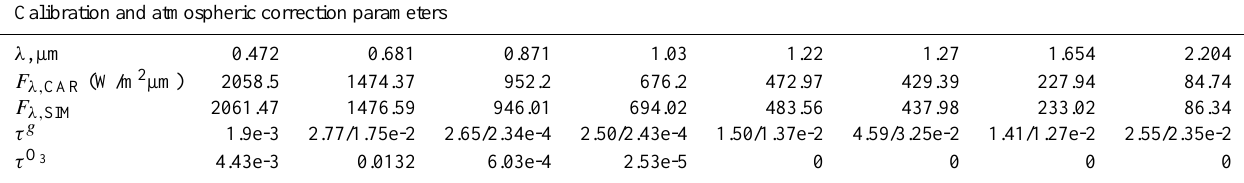
Table 1. Center wavelengths of CAR bands 3–8, 10, 13, in-band solar irradiance used in CAR calibration, solar irradiance based on the Spectral Irradiance Monitor (SIM) instrument on SORCE for 8 April 2008, and absorption optical thickness of atmospheric gases and ozone.